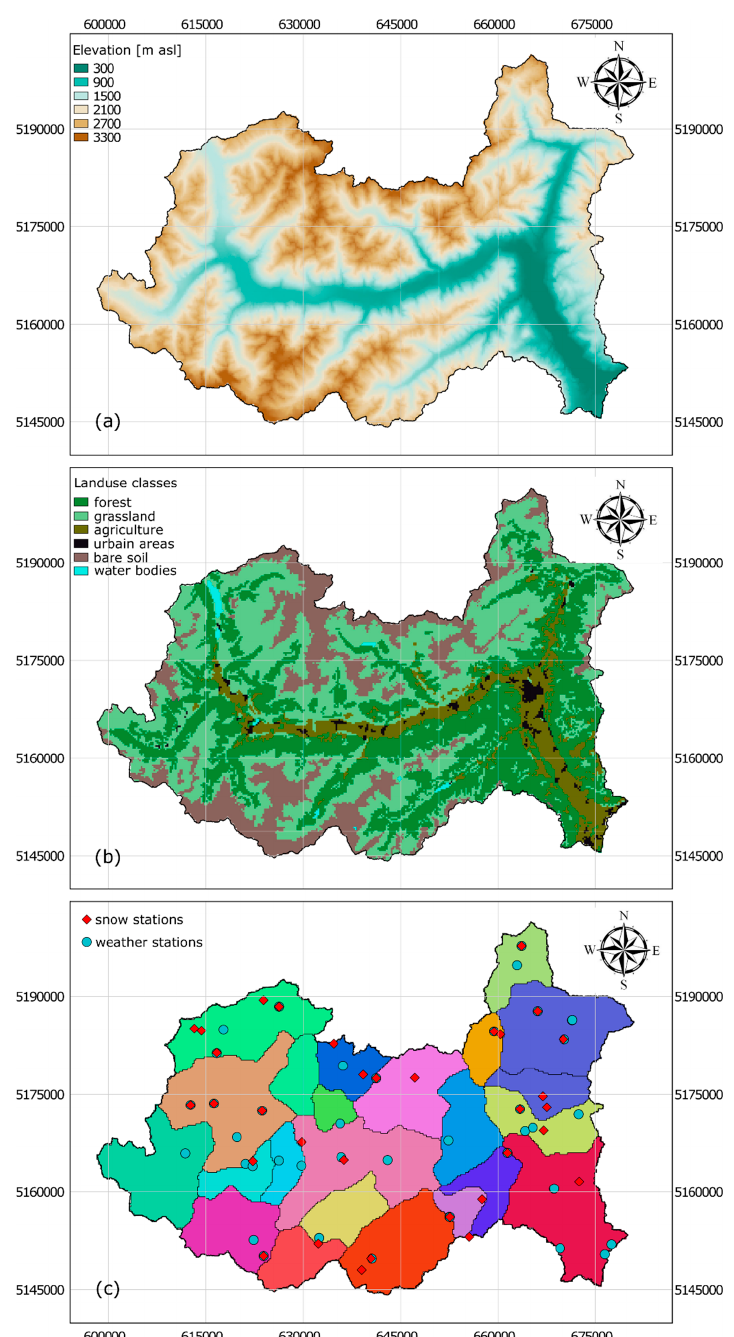
Figure 1. Study area: ( a ) Digital Terrain Model (250 × 250 m) of the upper Adige river catchment closed at the Ponte Adige stream gauge (2179 km 2 ); ( b ) land use distribution; ( c ) location of the weather stations (precipitation and temperature gauges) and of the snow stations and subdivision of the main study basin into sub-basins.